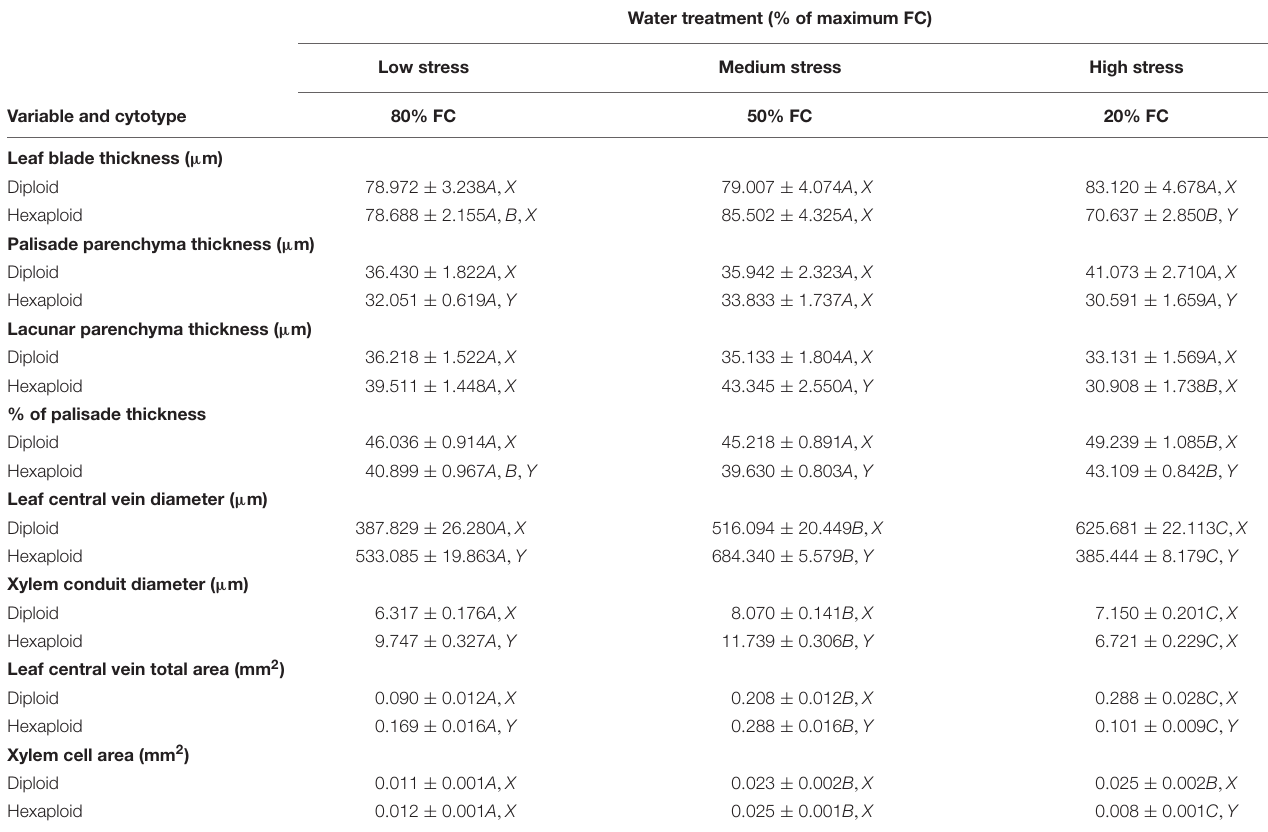
TABLE 3 | Anatomical characteristics of leaf blade and leaf central vein from diploid and hexaploid C. angustifolium under three different soil water treatments (80% of maximal FC, 50% FC, and 20%